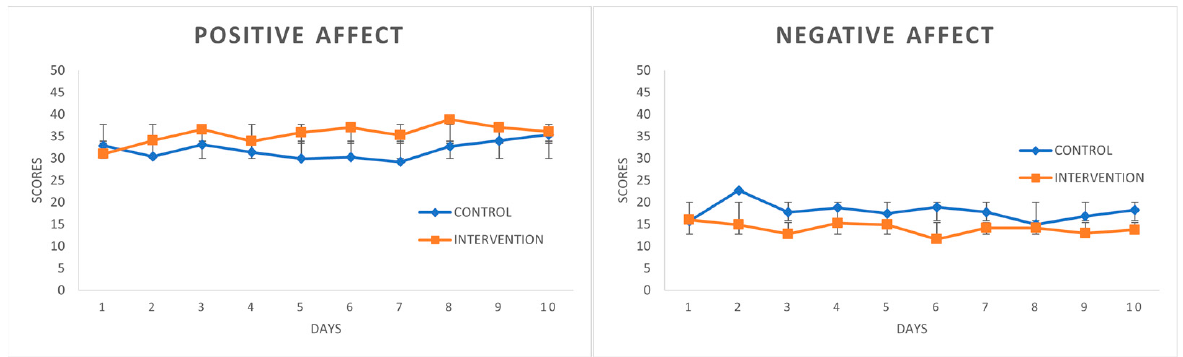
Figure 2. PANAS variables in control condition and intervention condition. Mean values (SD).